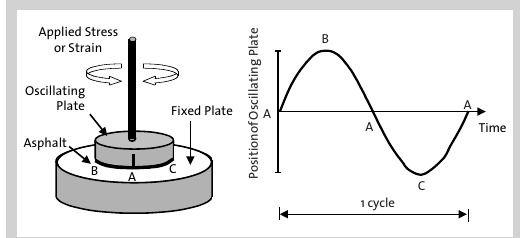
Figure 1: Dynamic Shear Rheometer (DSR)